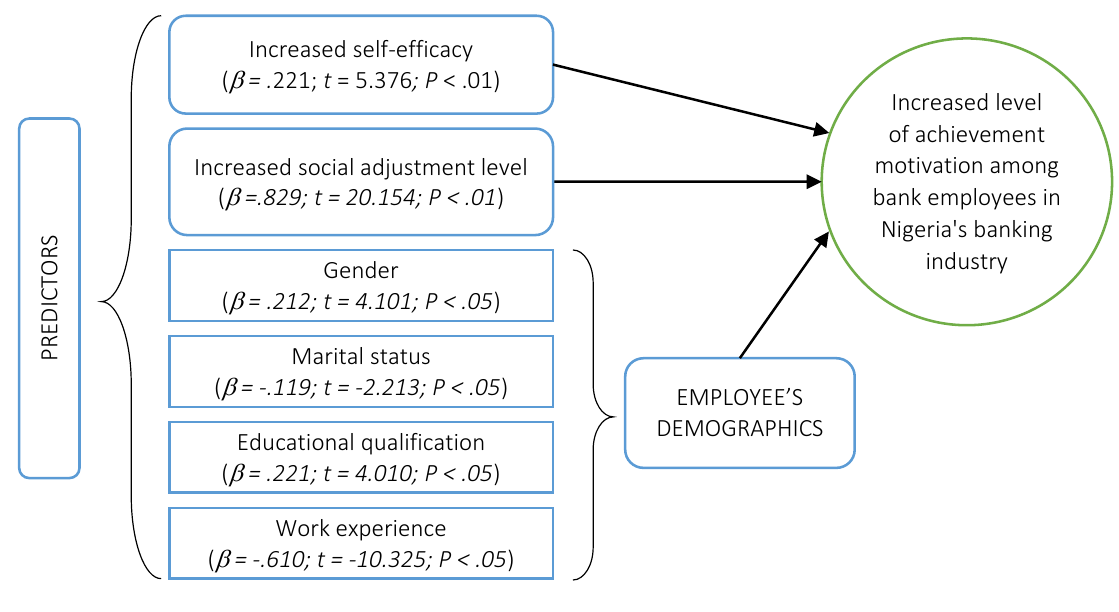
Figure 1. Practical model of effectively promoting achievement motivation in Nigeria’s banking